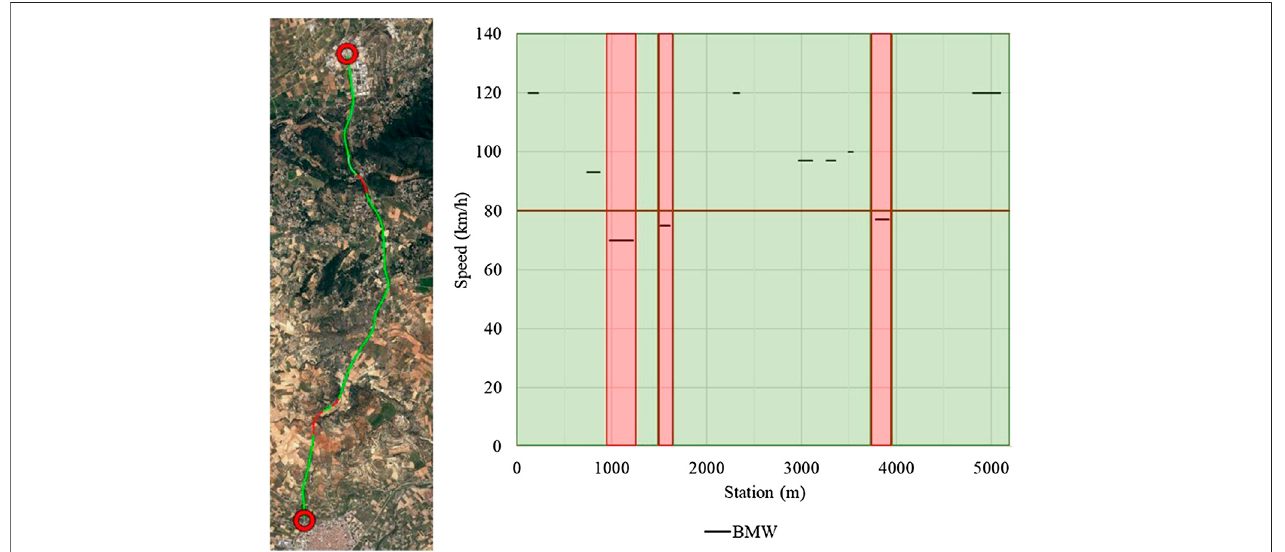
FIGURE 4 | ODD-compatible sections (in green) for the BMW vehicle traveling at 80 km/h.